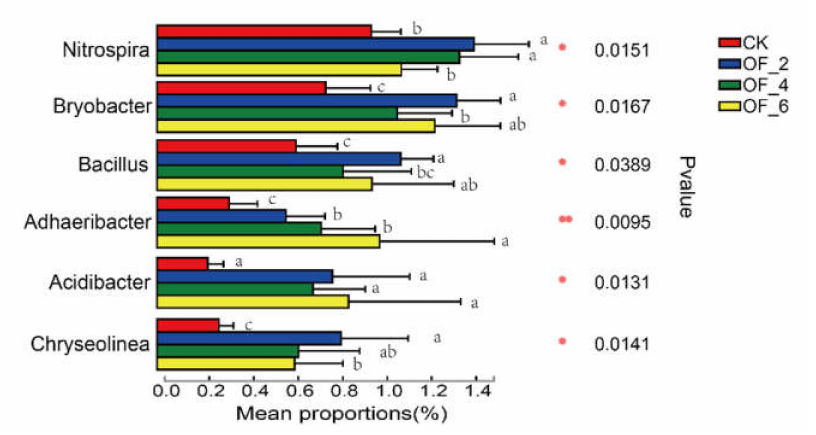
Figure 8. Bacteria with significant differences between treatment groups at the mature stage (genus level).